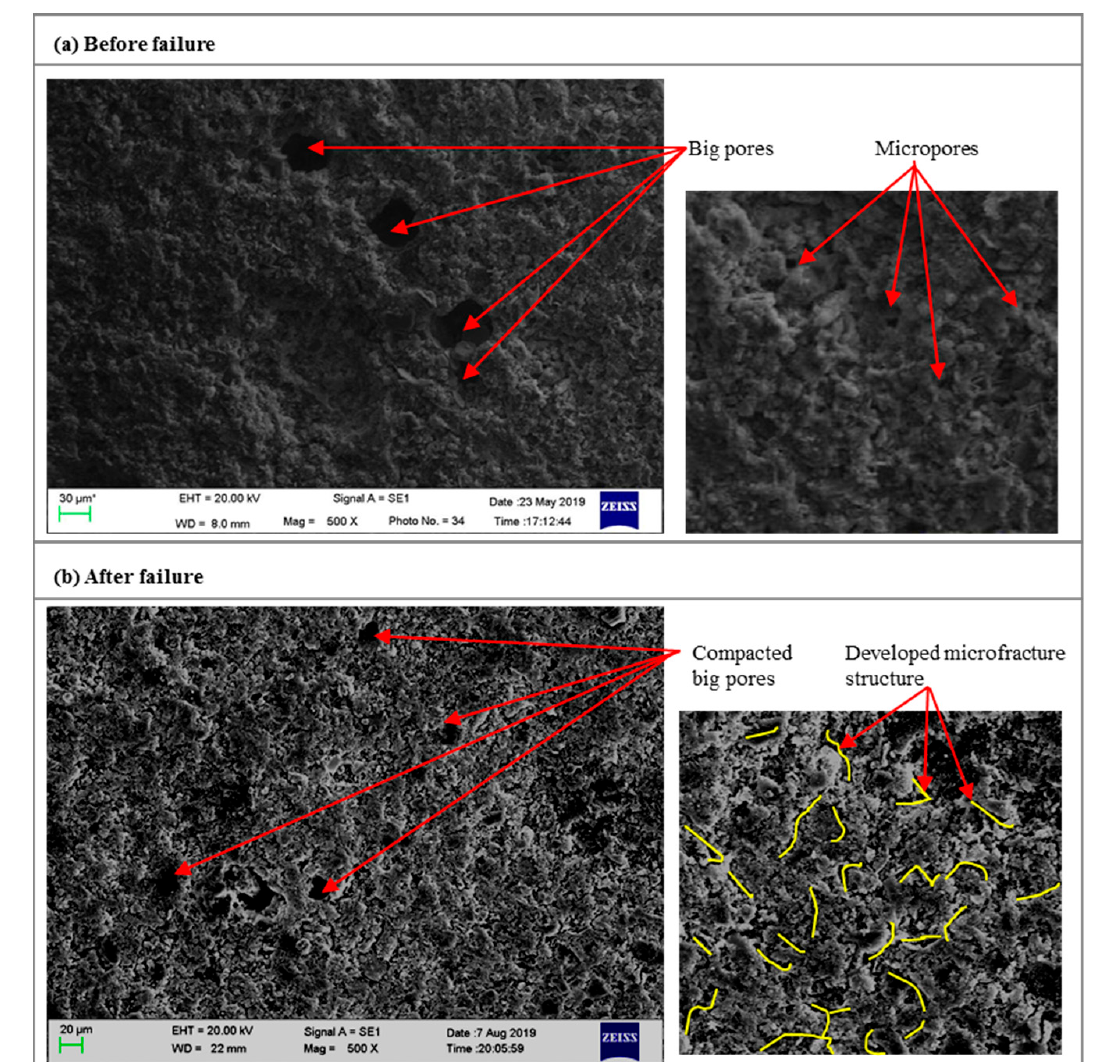
Figure 17. Observation on the fracture surface of the ECTB sample before and after failure by SEM. ( a ) Before failure: cracks and fractures were developed and had many large pores, ( b ) After failure: fractures were strongly developed, exhibiting irregular crossing branches, and most of the larger pores were compressed or compacted.